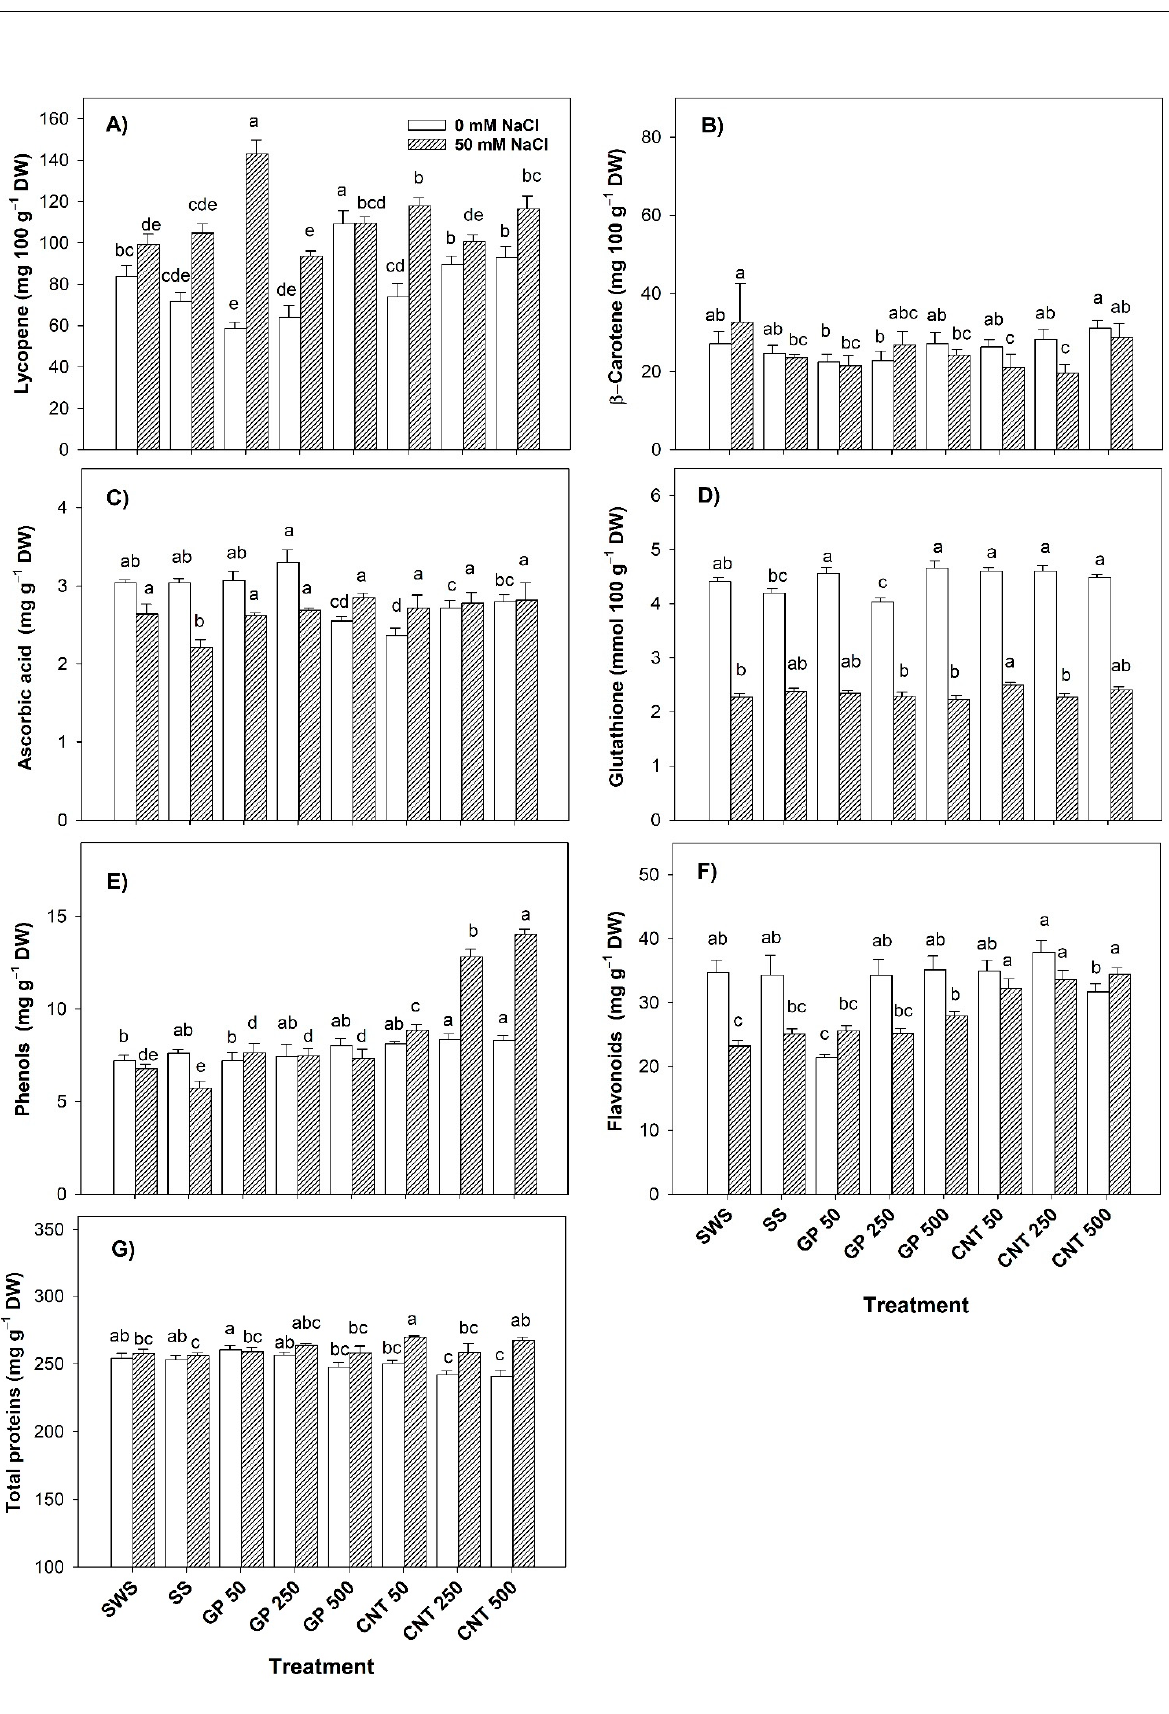
Figure 6. Bioactive compounds in fruits of tomato plants treated with carbon nanomaterials